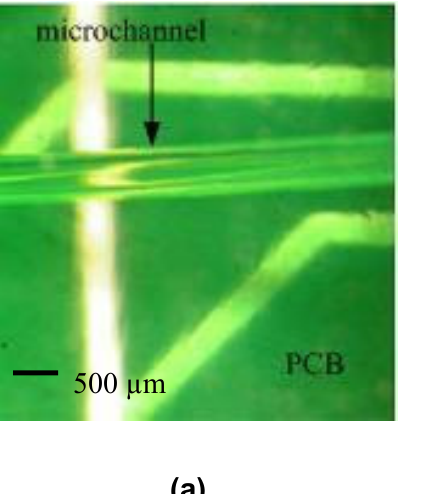
Figure 4. Microstructures fabricated using direct-dispense technique. (a) Microscopic image of a fabricated 500 µm diameter microchannel on a Printed Circuit Board (PCB). (b) Serpentine microchannel with an inner diameter of 150 µm and 200 µm outer